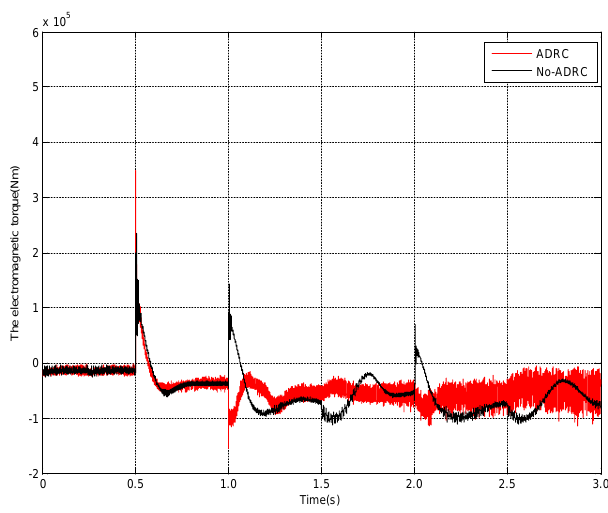
Figure 21. Simulation curve of the q -axis current.